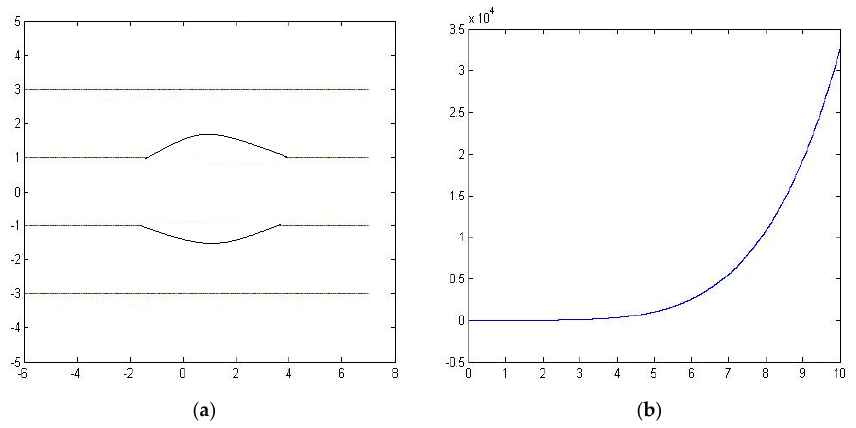
Figure 12. The performance of interpolation and extrapolation for the fluid flow around a circular obstacle. ( a ) Particle paths obtained by our method, ( b ) The error curve.